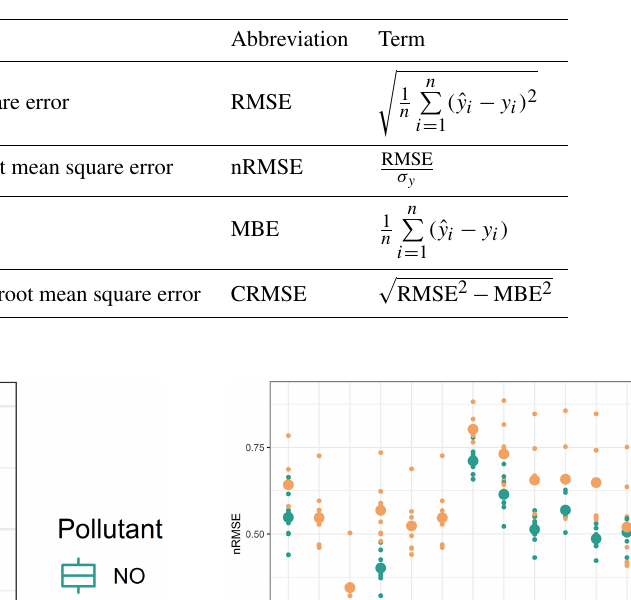
Table 2. Statistical metrics visualized in target diagrams. In the terms in the third column, ˆ y i represents a concentration measurement with a calibrated low-cost sensor, and y i represents the corresponding concentration measurement with the reference instrument; σ ˆ y and σ y are the empirical standard deviations of sensor and reference data.